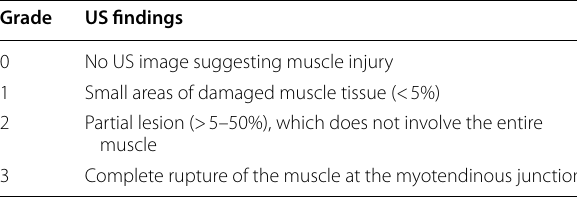
Table 1 US grading of intrinsic muscle injuries